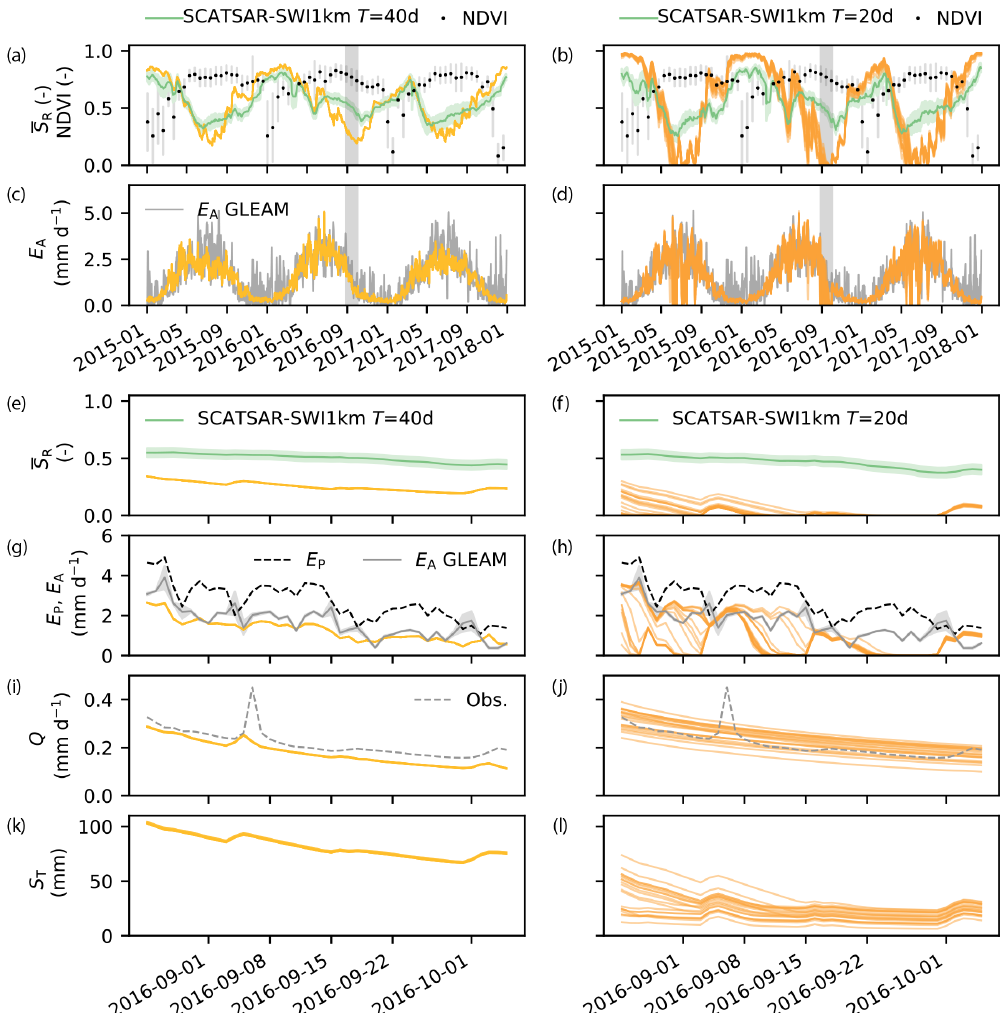
Figure 8. (a,b) Modeled relative root-zone soil moisture S R , SCATSAR-SWI1km Soil Water Index with optimal T value and NDVI for the period 2015–2017 for GR4H (yellow) and M5 (orange), respectively. The error bars and bands show the standard deviation of the remote- sensing data within the catchment area. (c, d) Actual evaporation E A by GR4H and M5 for the period 2015–2017, showing a large reduction of evaporation during summer for M5, unlike GR4H and GLEAM actual evaporation. (e, f) Zoomed-in modeled S R and SCATSAR-SWI1km root-zone soil moisture for the grey shaded period of September 2016 in (a) , (b) , (c) , and (d) . (g, h) Potential, modeled and GLEAM actual evaporation, (i, j) modeled and observed streamflow Q , and (k, l) total storage S T for the September 2016 dry period. The narrow uncertainty band of the GR4H model is related to its converging parameter search